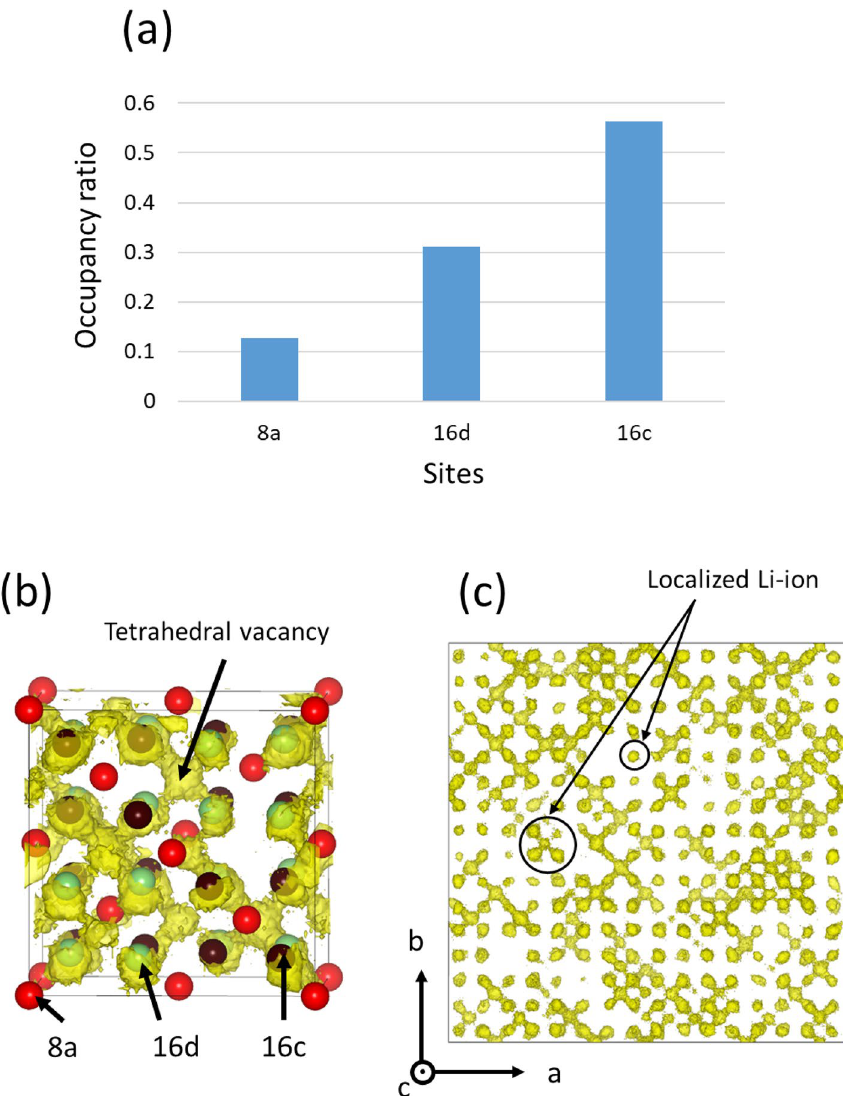
Figure 7. Li-ion array in Model 4 (4.5 mol% Li excess, 1.5 mol% Al deficiency) calculated by molecular dynamics (MD) at 973 K. ( a ) Occupancy ratio of Li ions among 8a, 16d, and 16c sites obtained by integration of Li population density within a radius of 1.2 Å centered at each site. Total occupancy ratio for 8a, 16d, and 16c sites set as unity. ( b ) Population density distribution of Li ions (yellow iso-surface) obtained by force field molecular dynamics (FFMD) calculations at 973 K for a 4 × 4 × 4 supercell folded into a 1 × 1 × 1 conventional spinel lattice. The red, green, and brown spheres represent 8a, 16d, and 16c sites, respectively. ( c ) Population density distribution of Li ions without folding of the